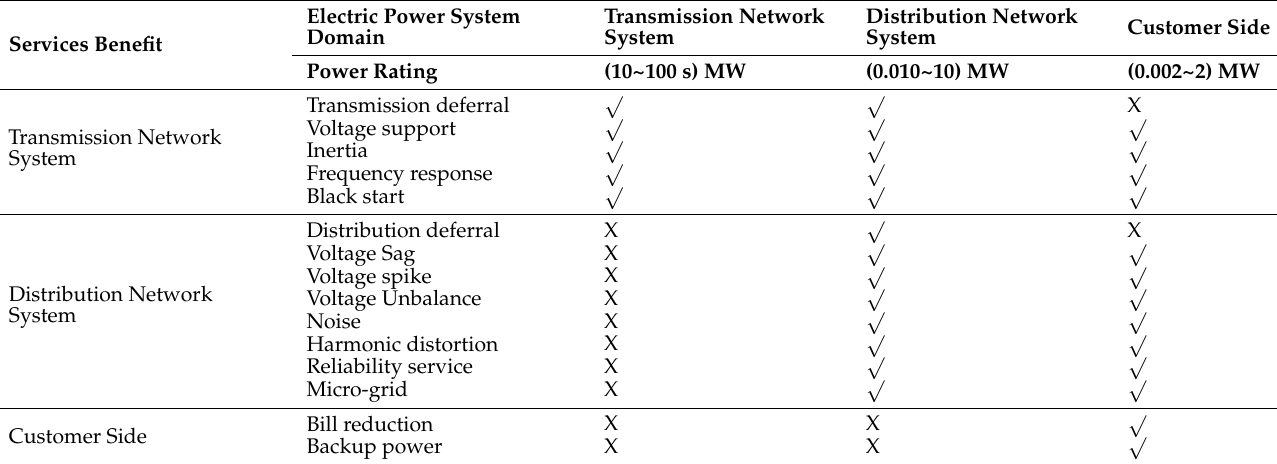
Table 1. Categorization of ESS applications using the physical locations in the electric power system domain for ESS and the benefit of services. Adapted with permission from ref. [31]. Copyright 2020. Elsevier. Services